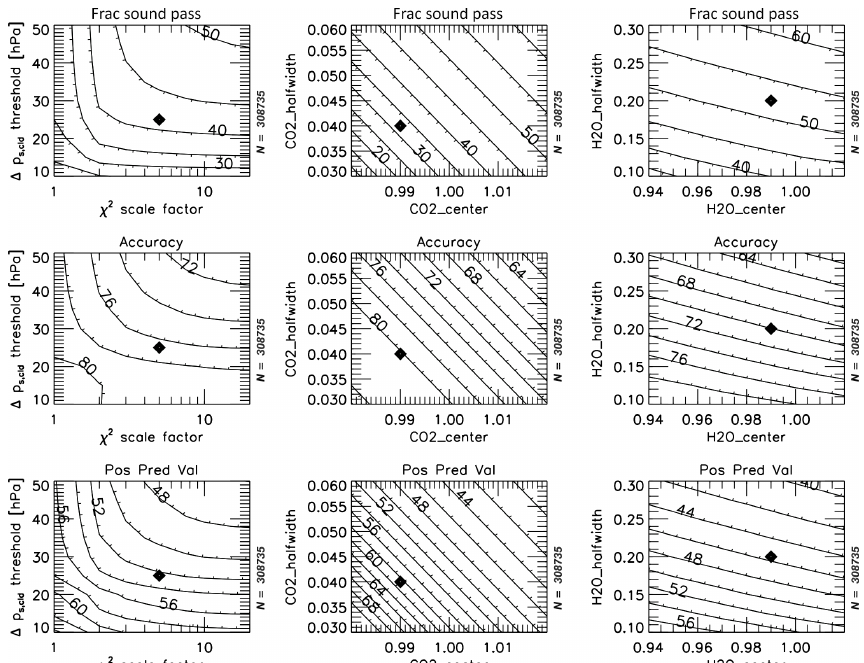
Figure 5. Contour plots of the May nadir-land data showing the fraction of soundings passing (top row), agreement (middle row) and positive predictive value (bottom row) for variations in the ABP (cid:49)p s , cld versus χ 2 scale factor (left column), IDP R CO (right column). Contours are drawn at increments of 5% for the fraction passing and 2% for the agreement and positive predictive values. The black diamond represents the threshold settings adopted for the analysis presented in this